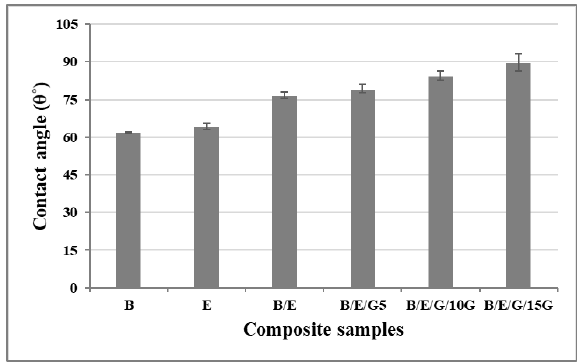
Figure 5. Contact angle measurement for composite samples.